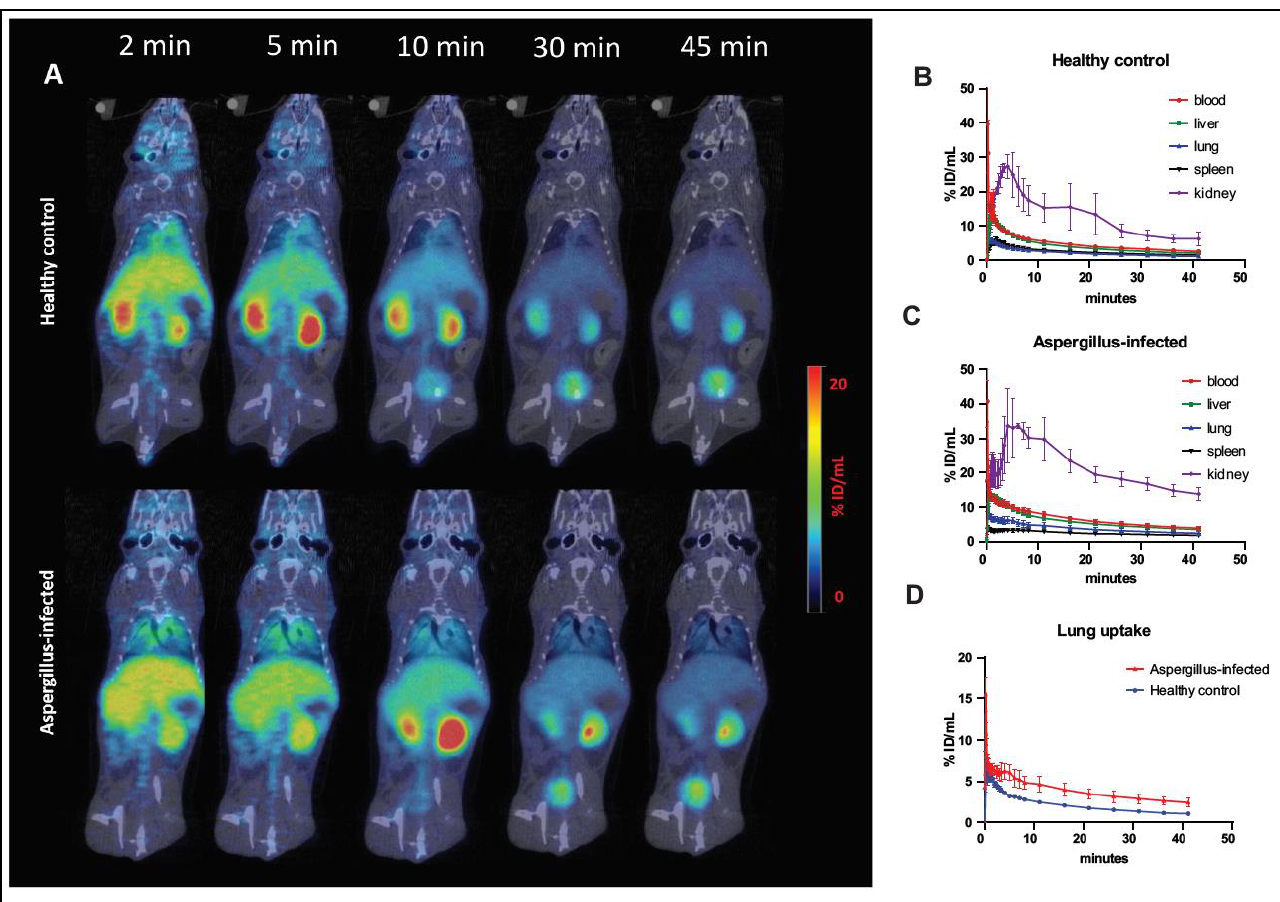
Figure 2. Dynamic PET/CT imaging with 2-[ 18 F]-fluorodeoxysorbitol (FDS) in mice with A. fumigatus pulmonary infection and healthy controls. ( A ) Representative serial coronal sectional PET/CT images are shown. ( B ) FDS time–activity curves of various organs in control animals. ( C ) FDS time–activity curves of various organs in Aspergillus -infected animals. ( D ) FDS time–activity curves of lungs in control animals and Aspergillus -infected animals. Data are expressed as means ± SEM. (%ID/mL: %Injected dose/mL).